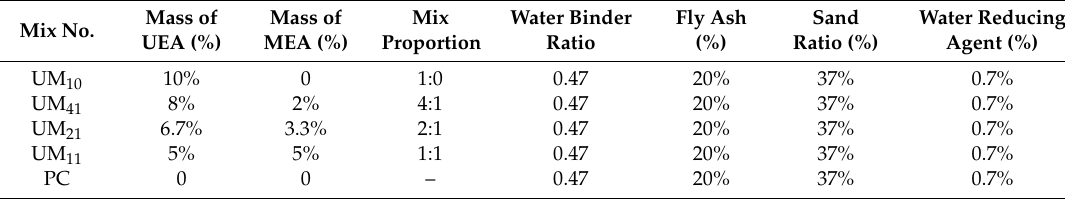
Table 5. Shrinkage-compensating concrete mix